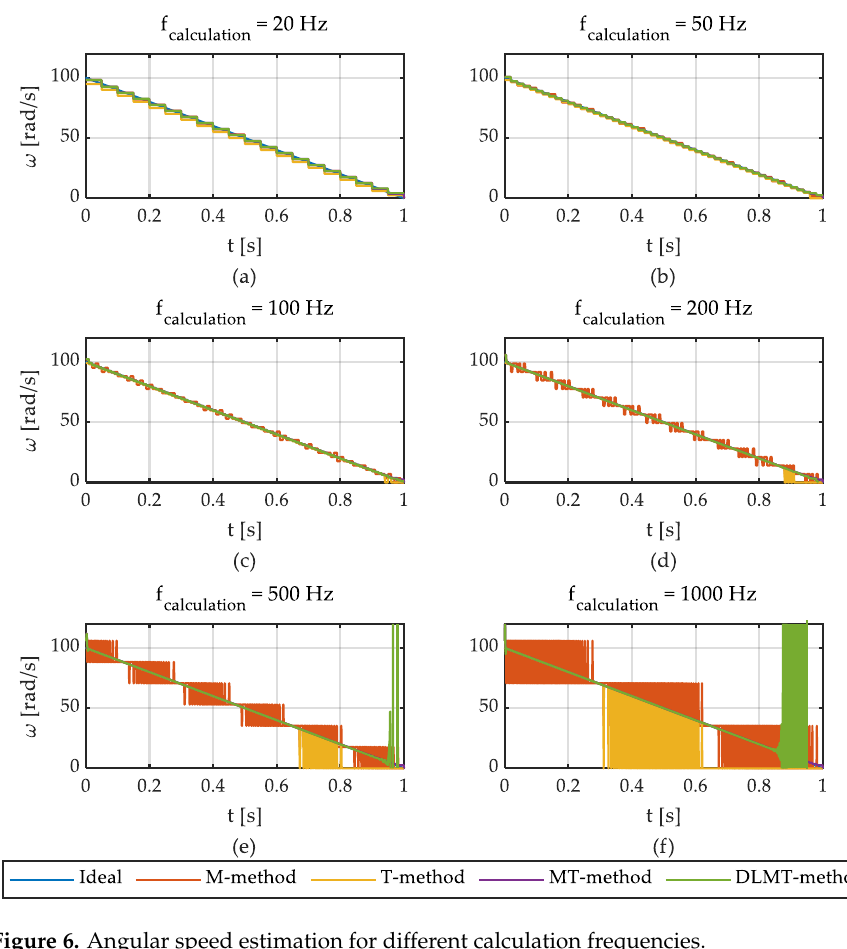
Figure 6. Angular speed estimation for different calculation frequencies.